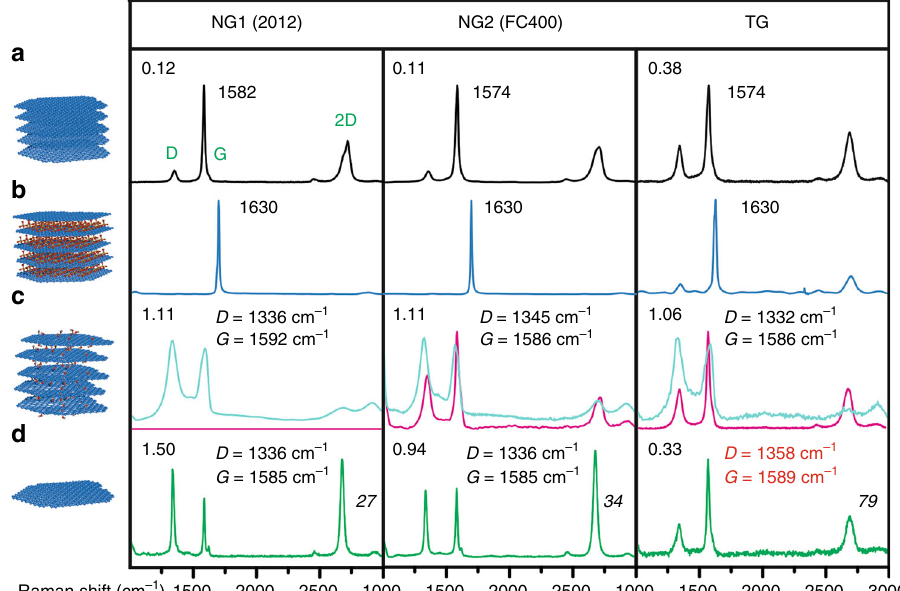
Fig. 3 Raman study on the intercalation of natural graphite grades (NG1, NG2) and turbostratic graphite (TG). a Averaged Raman spectra of pristine graphites (black spectra). b Average spectra of graphites after treatment at intercalation reaction conditions to form stage-1 graphite sulfate (dark-blue spectra). c Extracted single spectra of recorded maps after water addition and sonication: Oxidized graphite (bright-blue) and unoxidized areas found in NG2 and TG (magenta). d Raman spectra of fl akes of graphene from NG1 isolated by centrifugation, Raman spectra of graphene from NG2 from the supernatant, and Raman spectra from TG from smaller shards of graphite (green spectra). See also Supplementary Methods